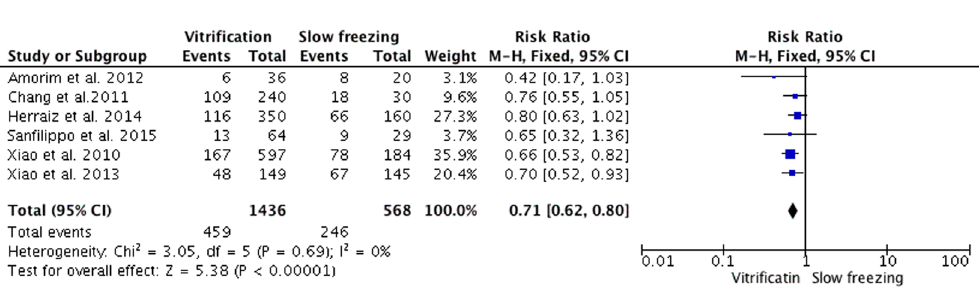
Figure 2. Random effect model of odds ratio with 95% CIs of the proportion of intact primordial follicles: slow freezing versus vitrification.